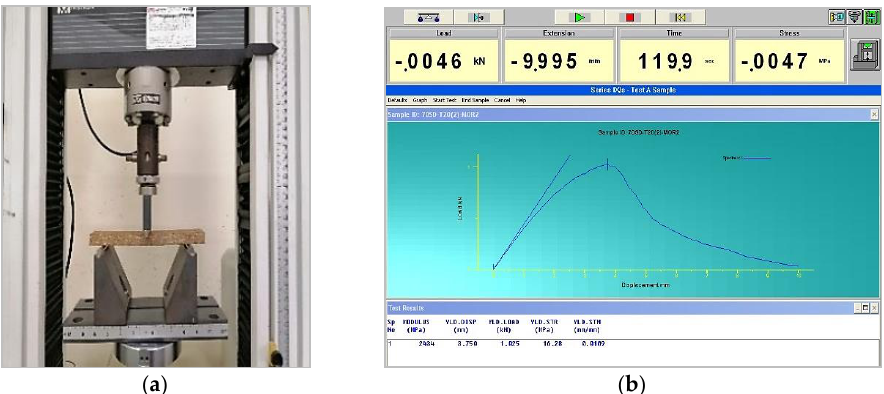
Figure 10. Mechanical properties for each particleboard determined by ( a ) the specimen tested using Universal Testing Machine; ( b ) after failure, the graph and value for Modulus of Elasticity (MOE) and Modulus of Rupture (MOR) appeared on screen.